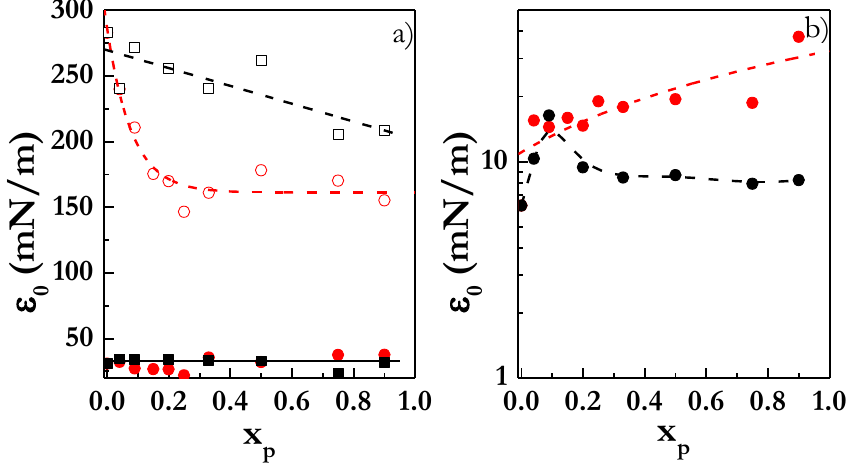
Figure 5. ( a ) Dependences on x p of the maximum values of ε 0 for the LE (CB ( ■ ) and SiO 2 (●) particles) and LC (CB (□) and SiO 2 ( ○ ) particles) phases; ( b ) dependence on x p of the maximum values of ε 0 for the phase coexistence region (CB ( ■ ) and SiO 2 (●) particles). Notice that the lines are guides for the eyes.